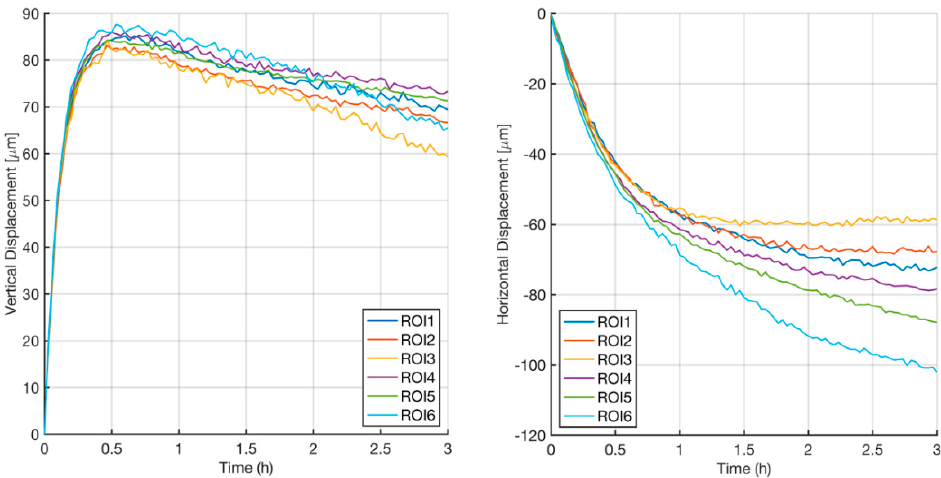
Figure 10. Measured vertical (left) and horizontal (right) shifts for each ROI in a wet experiment. The results are shown for sample 1, but similar graphs were obtained for all the measured samples.